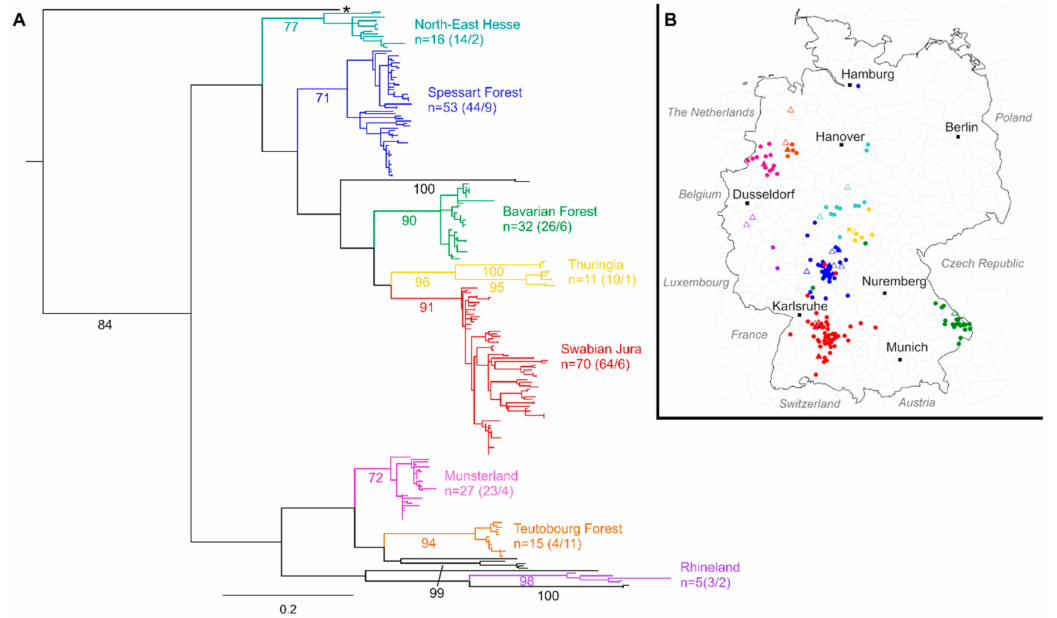
Figure 1. ( A )—Phylogenetic analysis of Puumala virus S segment sequences. Human sequences stem from samples referred to the German National Hantavirus Consultation Laboratory, 2004–2018. Rodent sequences were downloaded from Genbank. A detailed list of included sequences is given in Supplementary Information S2. Maximum likelihood tree based on a 504 nt alignment, calculated using the HKY85 + G + I model of nucleotide substitution is shown. Scale bar indicates nucleotide substitutions per site. Bootstrap values (500 iterations) are given in percent for relevant clades. The tree was rooted by a human-derived sequence from Finland (accession number EU833888, not shown). Colors indicate phylogeographic clusters; black branches refer to sequences not yet assigned to any clear-defined phylogeographic cluster. n = number of sequences within the respective cluster (human origin / rodent origin). The sequence marked with a star stems from a patient with a travel history and known rodent exposure abroad. ( B ) Map showing the allocation of Puumala virus sequences in Germany. Circles indicate human-derived sequences; triangles indicate rodent-derived sequences. Multiple sequences originating from the same location are depicted only once for visibility. Colors are according to clusters in the phylogenetic tree ( A ). Black squares indicate major German cities to facilitate